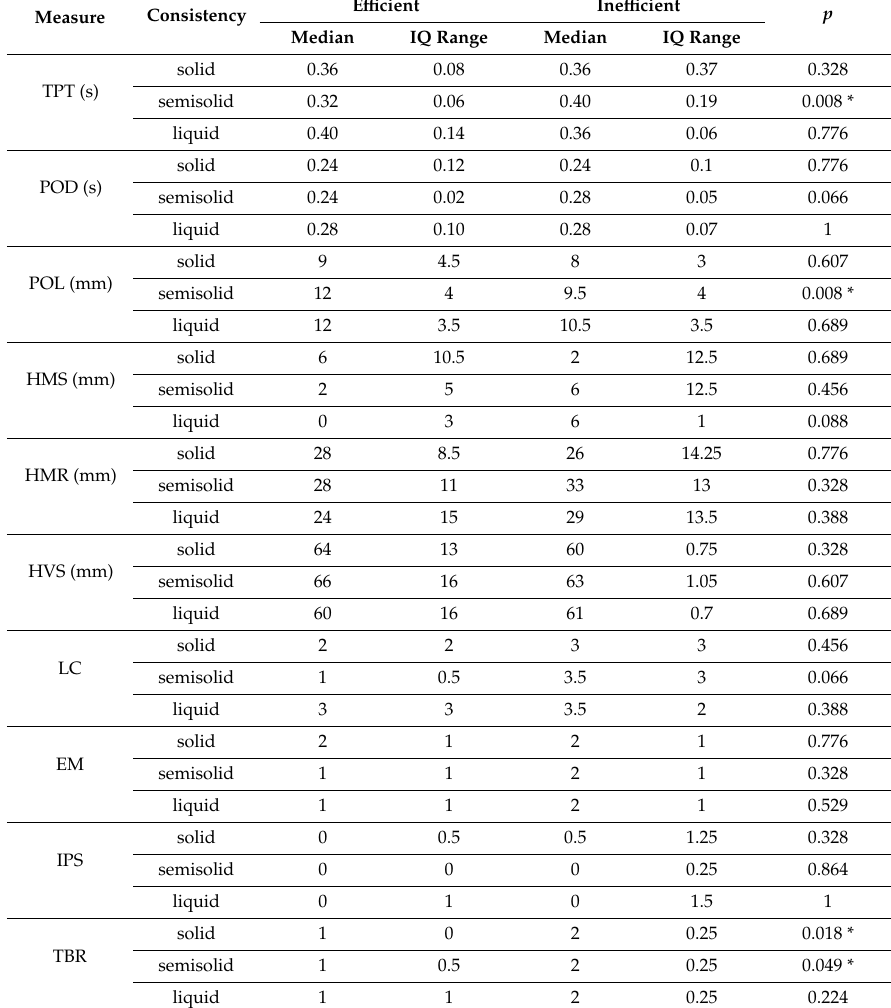
Table 2. Comparisons of videofluoroscopic measures in patients with efficient and inefficient